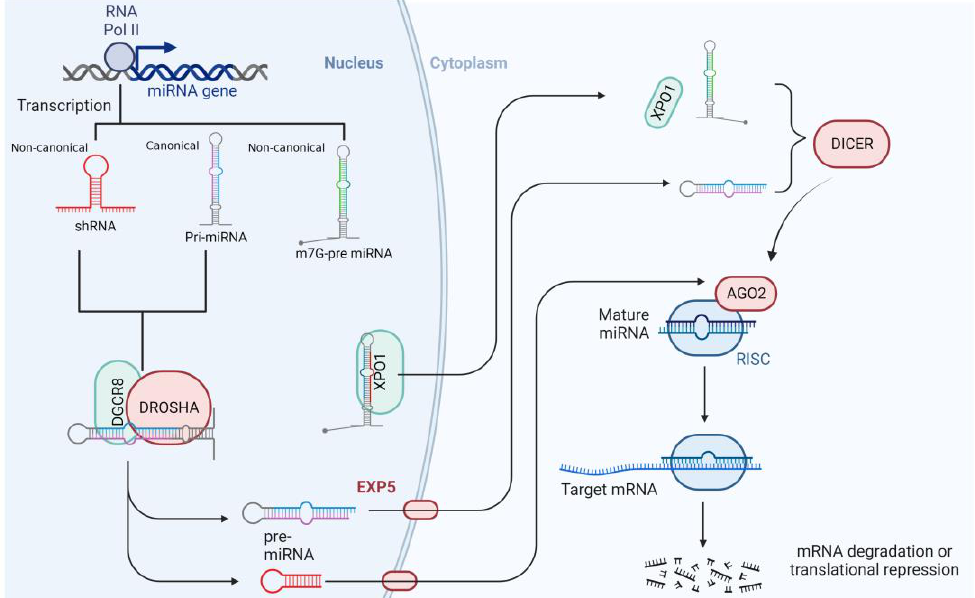
Figure 1. MiRNA biogenesis pathways. Schematic diagram of the canonical and non-canonical miRNA biogenesis process. In the canonical pathway, a primary miRNA transcript produced by RNA polymerase II is processed by the Drosha microprocessor in the nucleus. The generated pre-miRNA is transported to the cytoplasm in an EXP5-Ran GT-dependent manner and further processed by the Dicer microprocessor to generate a mature miRNA. The mature miRNA is loaded onto RISC to inhibit the translation of a target mRNA to conduct degradation. The non-canonical pathway is Drosha or Dicer dependent. AGO2, Argonaut protein 2; DGCR8, DiGeorge critical region 8; EXP5, exportin-5; RISC, RNA-induced silencing complex; XPO1, exportin-1.